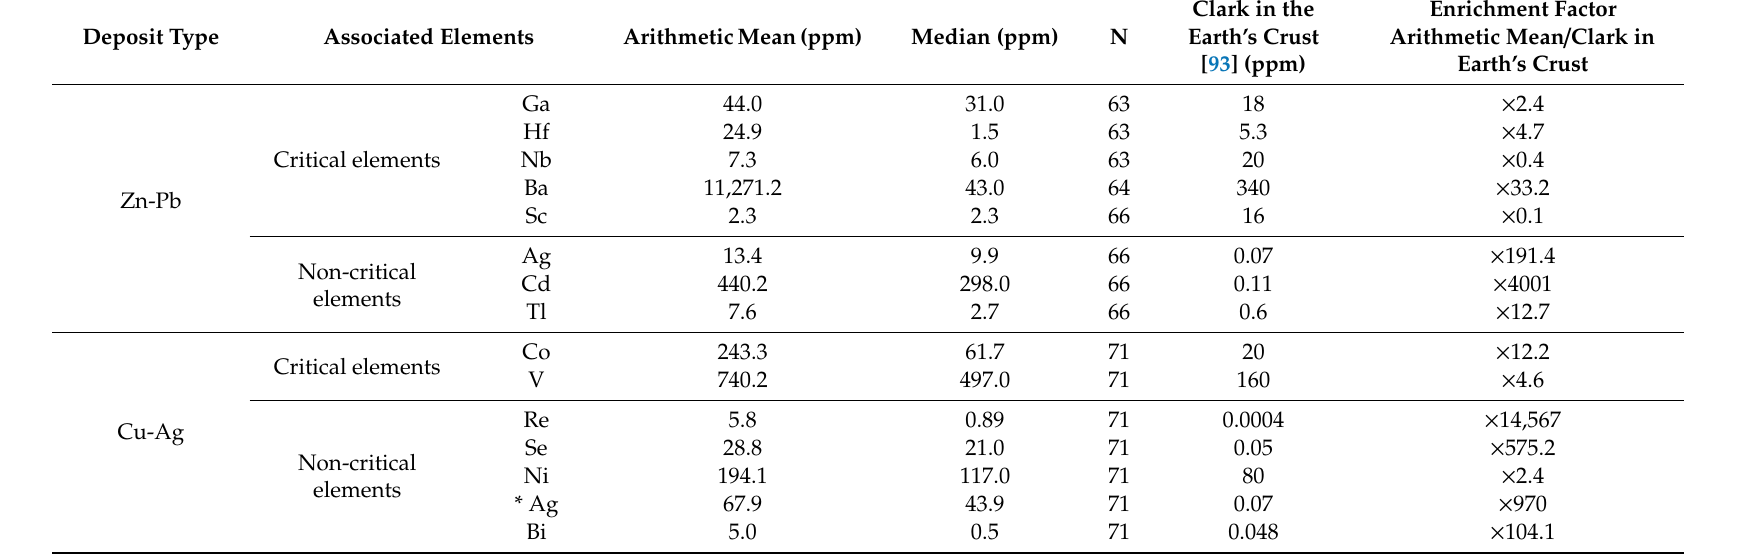
Table 11. Associated elements and enrichment factors relative to their abundances in the Earth’s crust after [93] in the Zn-Pb (MVT) and Cu-Ag (Kupferschiefer) sediment hosted deposits in